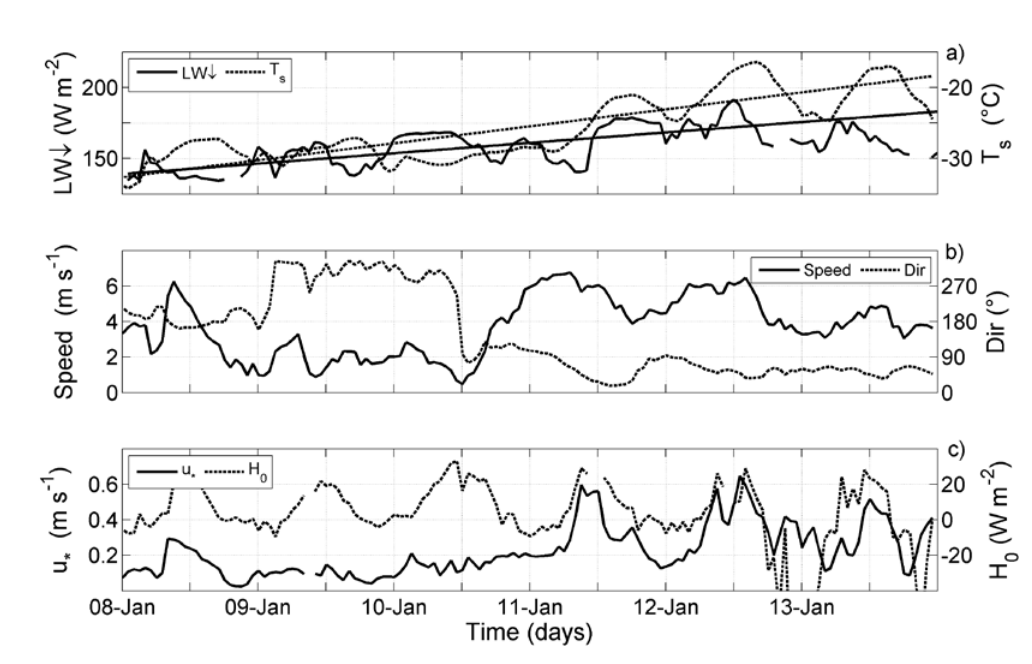
) and sonic temperature ( ) with superimposed the ) and momentum ( ) fluxes (c) for days 8- 𝐿𝑊 ↓ 𝑇 𝑠 𝐻 0 𝑢 ∗